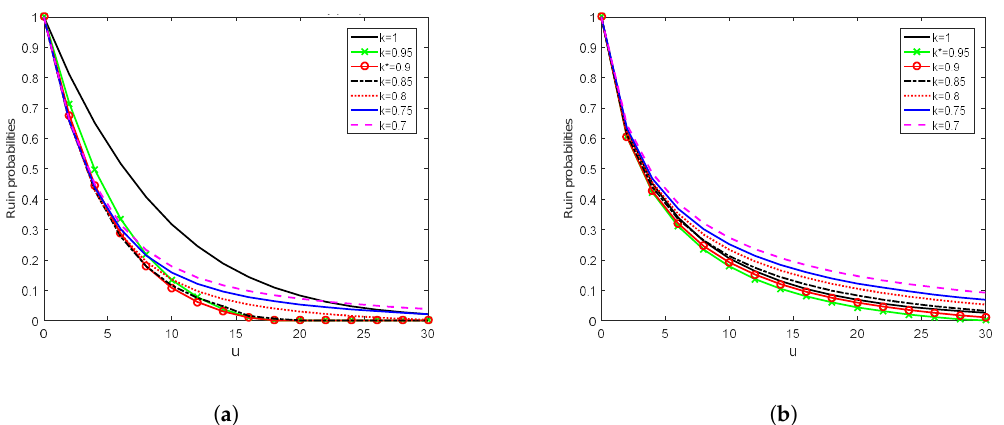
Figure 4. Ultimate ruin probabilities for the DPM compounded by proportional reinsurance and a constant force of interest; ( a ) DPM with interest force, Exp(0.5) claims; ( b ) DPM with interest force, Par(3,2)